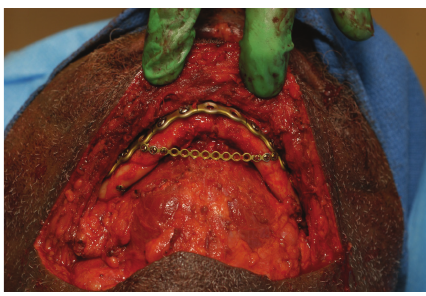
Figure 7: Spanning plate in a selected patient. Note that a different reconstructive plate was used on the anterior mandibular surface due to the multiple comminuted mandibular